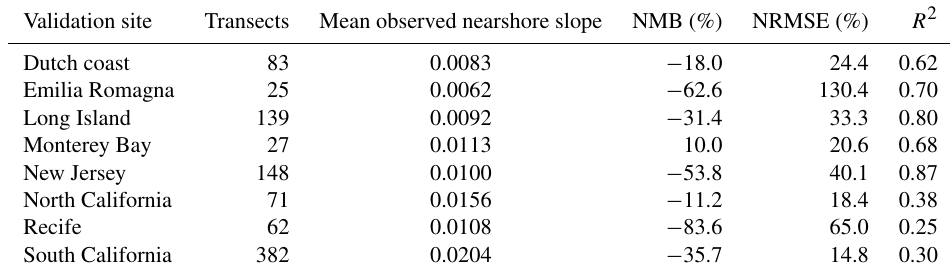
Table 2. Error statistics per validation site on the basis of the nearshore slopes tan( β ns